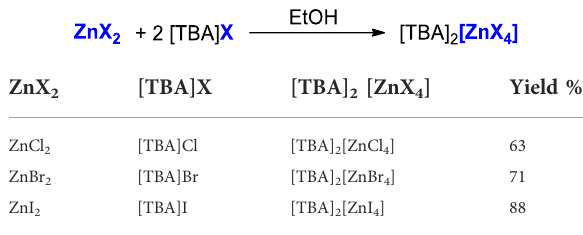
TABLE 1 Synthesis and characterization of the ammonium zincates a